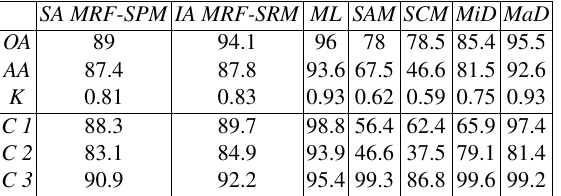
Figure 4: Class expectation ± 2 standard deviation contours; in the case of spatial independency between pixels. Table 1: Classification accuracy in percentage for each class of the simulated image, where OA , AA , k , SA MRF-SPM , and IA MRF-SRM represent the overall accuracy, average accuracy, kappa coefficient, spatially adaptive MRF-SPM , and improved adaptive MRF-SRM .